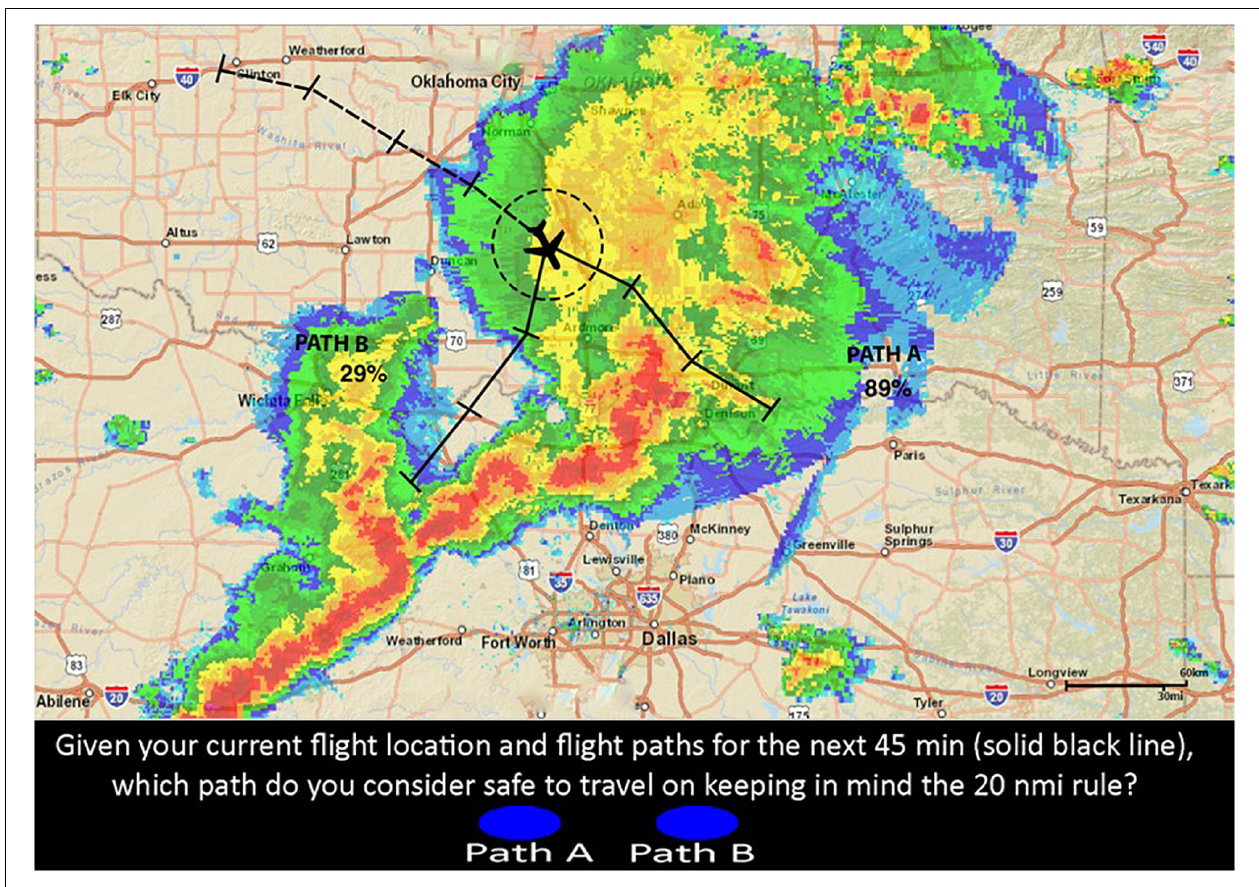
FIGURE 3 | Double route trial with RSAT. The disjunctive risk estimates are located near their corresponding paths and are 89% for Path A and 29% for Path B. The disjunctive risk represents the probability that at least one red-cell is forecasted to intersect each projected flight-path in the next 45 min of flight (the solid